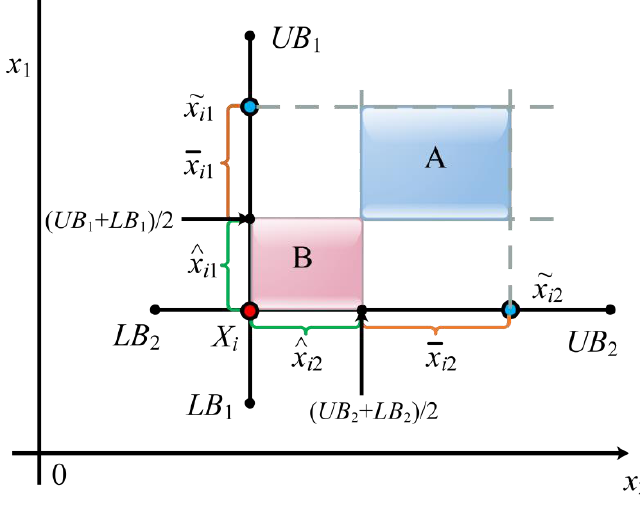
Figure 3. Schematic diagram of different learning methods in 2-D.